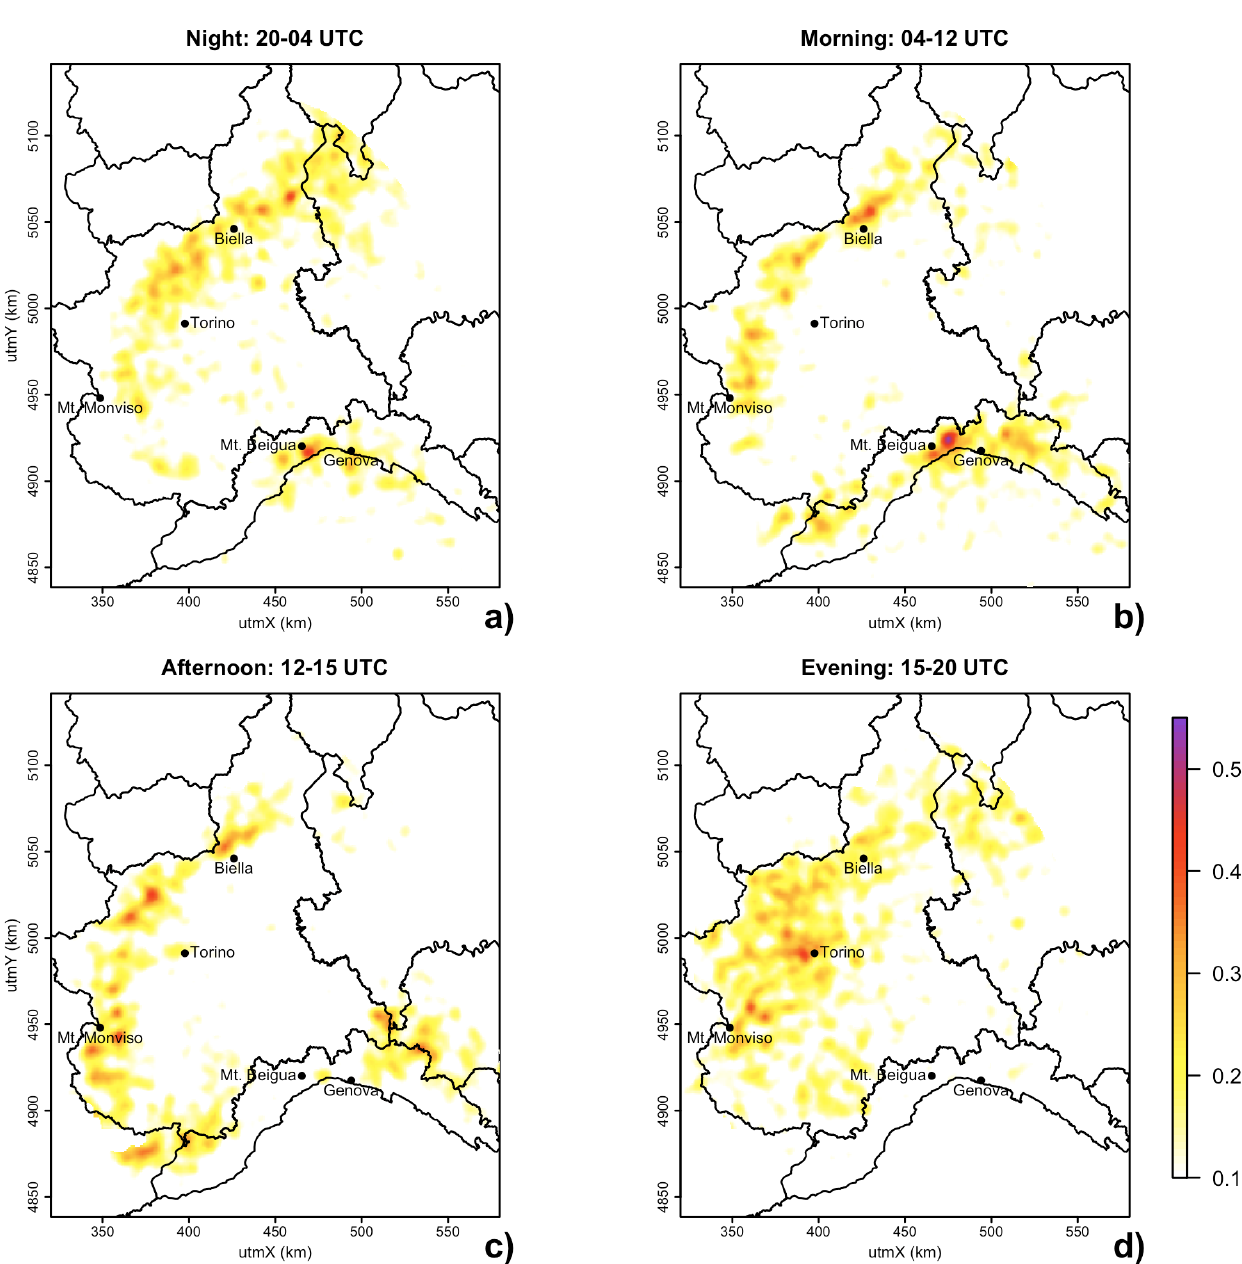
Figure 11. Spatial distribution of IDs density during different periods of the day: ( a ) night (20–04 UTC); ( b ) morning (04–12 UTC); ( c ) afternoon (12–15 UTC); and ( d ) evening (15–20